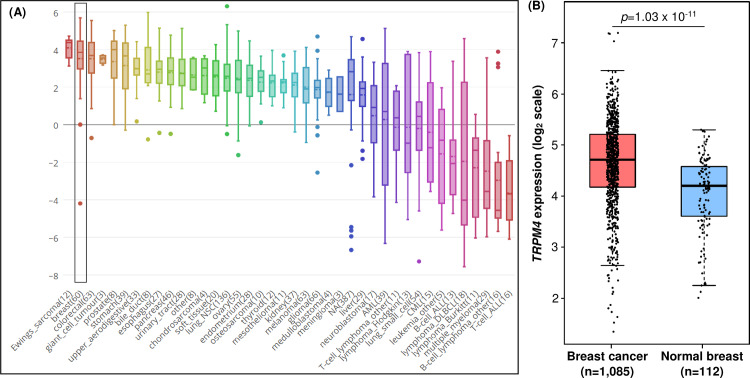
TRPM4 transcript expression profile in cancer cell lines and breast cancer cases.(A) TRPM4 transcript levels in cancer cell lines and each cancer type is represented by multiple cell lines (numbers in bracket denote total number of cell lines). Inset bracket denotes TRPM4 levels in breast cancer cell lines (n = 60). Data derived from the CCLE database (https://portals.broadinstitute.org/ccle). (B) TRPM4 transcript levels in TCGA series of breast cancer cases (n = 1,085) compared with normal breast tissues (n = 112) according to GEPIA2 (http://gepia2.cancer-pku.cn/) database.